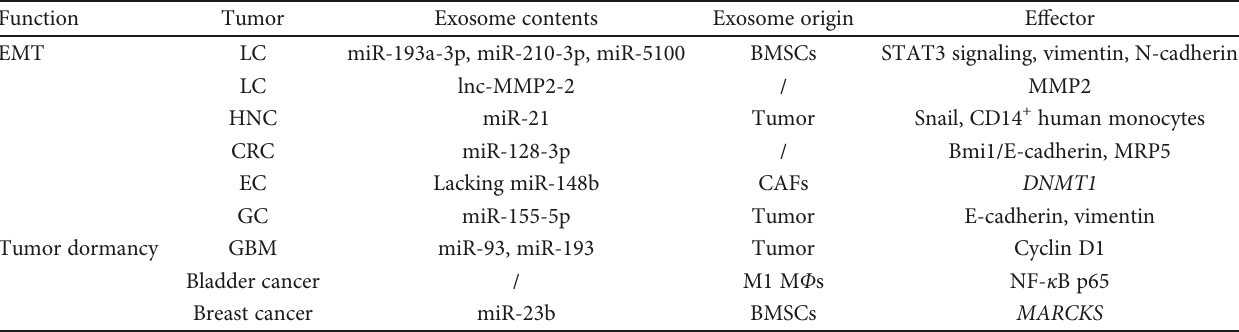
Table 2: Exosomes, EMT, and tumor dormancy.